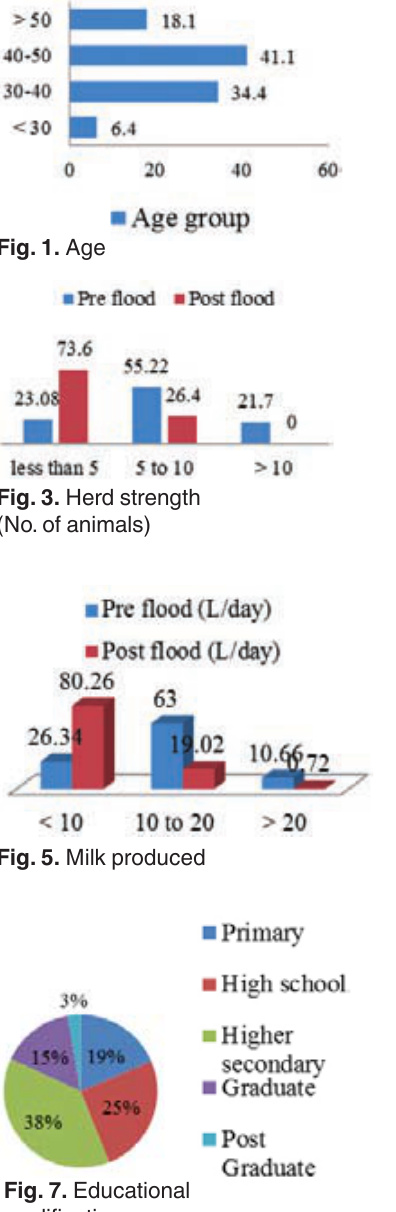
Fig. 7. Educational